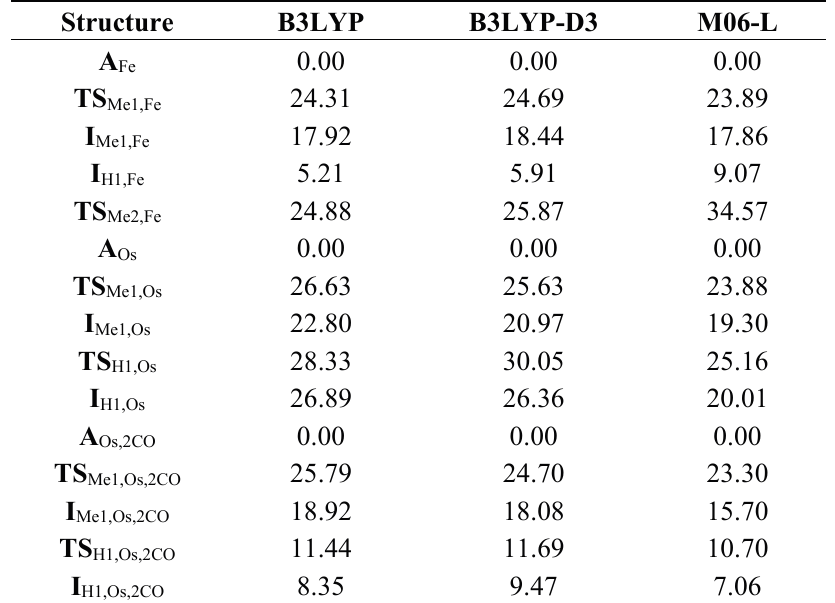
Table 1. Relative energies obtained with basis set BS2 through single point calculations on B3LYP/BS1 optimized geometries. All energies are in kcal·mol − 1 and contain ZPE